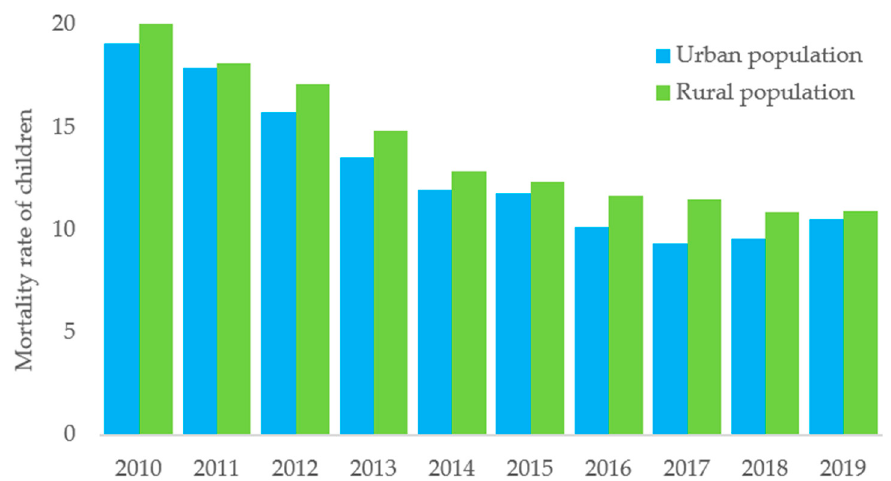
Figure 4. The mortality rate among the urban and rural population of children under 5 years of age per 1000 births. Source: Bureau of National Statistics of the Agency for Strategic Planning and Reforms of the Republic of Kazakhstan. Available online: https://stat.gov.kz/ (accessed on 26 May 2021).